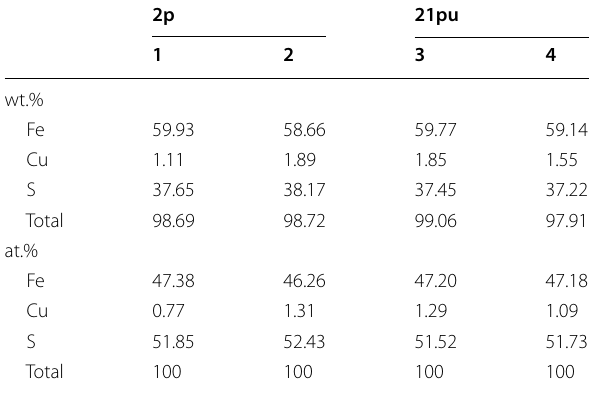
Table 2 Representative chemical compositions of